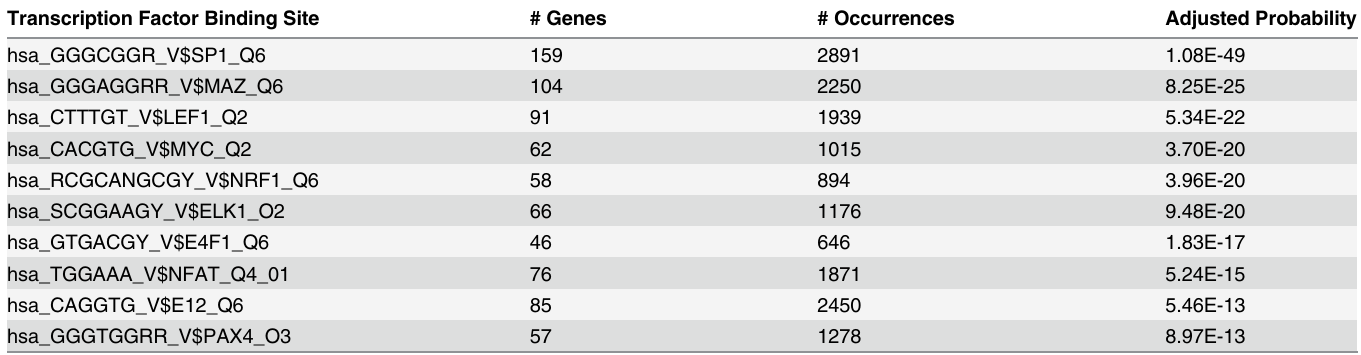
Table 4. Top 10 transcription factor binding sites significantly over-represented in the network of genes that were significantly upregulated in response to transient hypoxia in fetal pituitary. Transcription Factor Binding